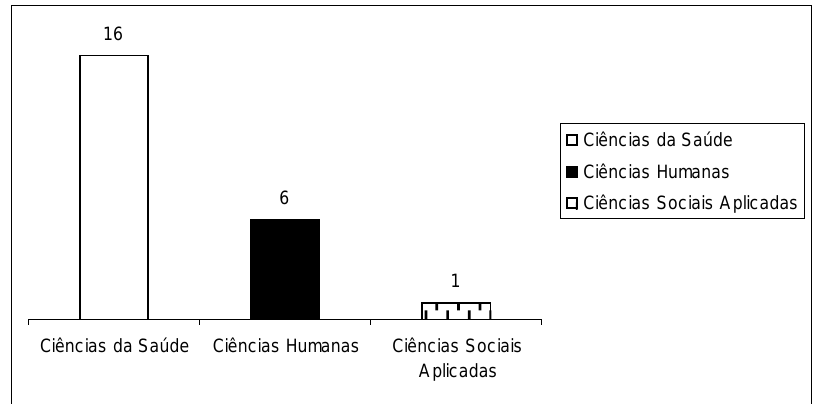
Figura 1. Distribuição dos grupos de pesquisa que estudam as atividades de aventura por área de conhecimento.